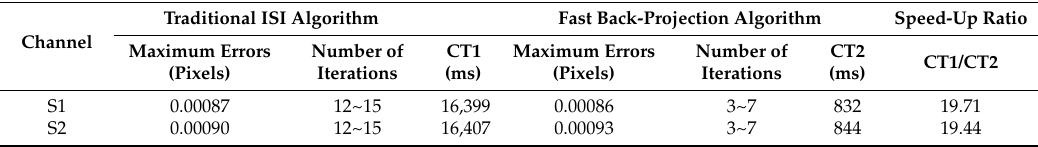
Table 3. Performance evaluation of the fast back-projection algorithm using 1 million points. Maximum errors: the maximum displacements between the calculated image points and the known ones; CT: computation time; ISI: image space